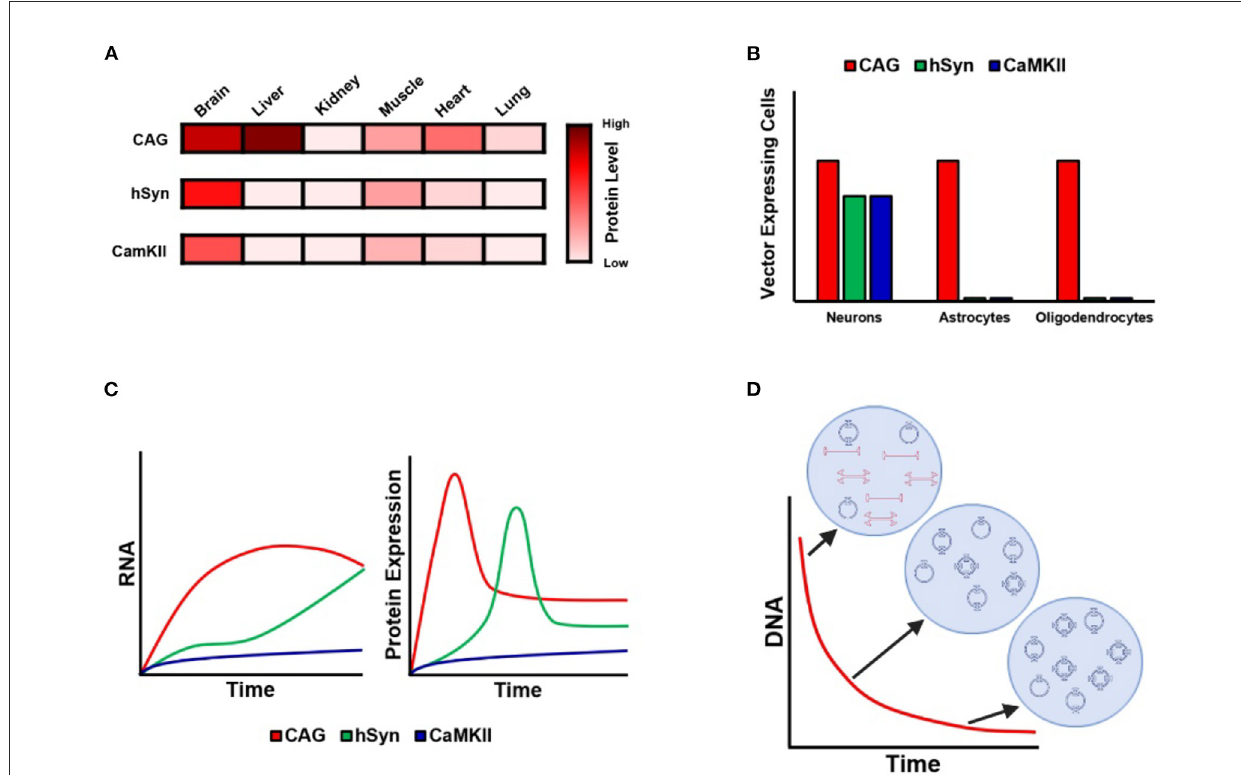
FIGURE1 Kinetics of AAV expression with ubiquitous and neuron-specific promoters. (A) Illustration of GFP protein expression in different organs following administration of PHP.eB employing CAG, hSyn, and CamKII promoters. Note that CAG evinces strong expression in the liver and heart, whereas hSyn and CamKII are associated with almost no expression outside the brain, with the exception of weak expression in skeletal muscle. Data from Finneran et al.. (B) Cell-type-specific expression of GFP under CAG, hSyn, and CamKII following AAV9 intraparenchymal injection into the striatum. Note that CAG is associated with expression in neurons, astrocytes, and oligodendrocytes, whereas expression is restricted to neurons in the case of hSyn and CamKII. Data from Hollidge et al.. (C) Diagram of the 6-month time-course of RNA and protein expression under CAG, hSyn, and CamKII following AAV9 intraparenchymal injection into the striatum. Note the different kinetic profile of expression for each promoter. Data from Hollidge et al.. (D) Diagram of the 3-week time-course of vector DNA following AAV9 intraparenchymal injection into the striatum. Note that the total amount of vector DNA decreases continuously until stabilizing at 3 weeks, during which time the vector DNA forms stable circular episomes and concatemers of up to five vector copies per episome. Data from Hollidge et